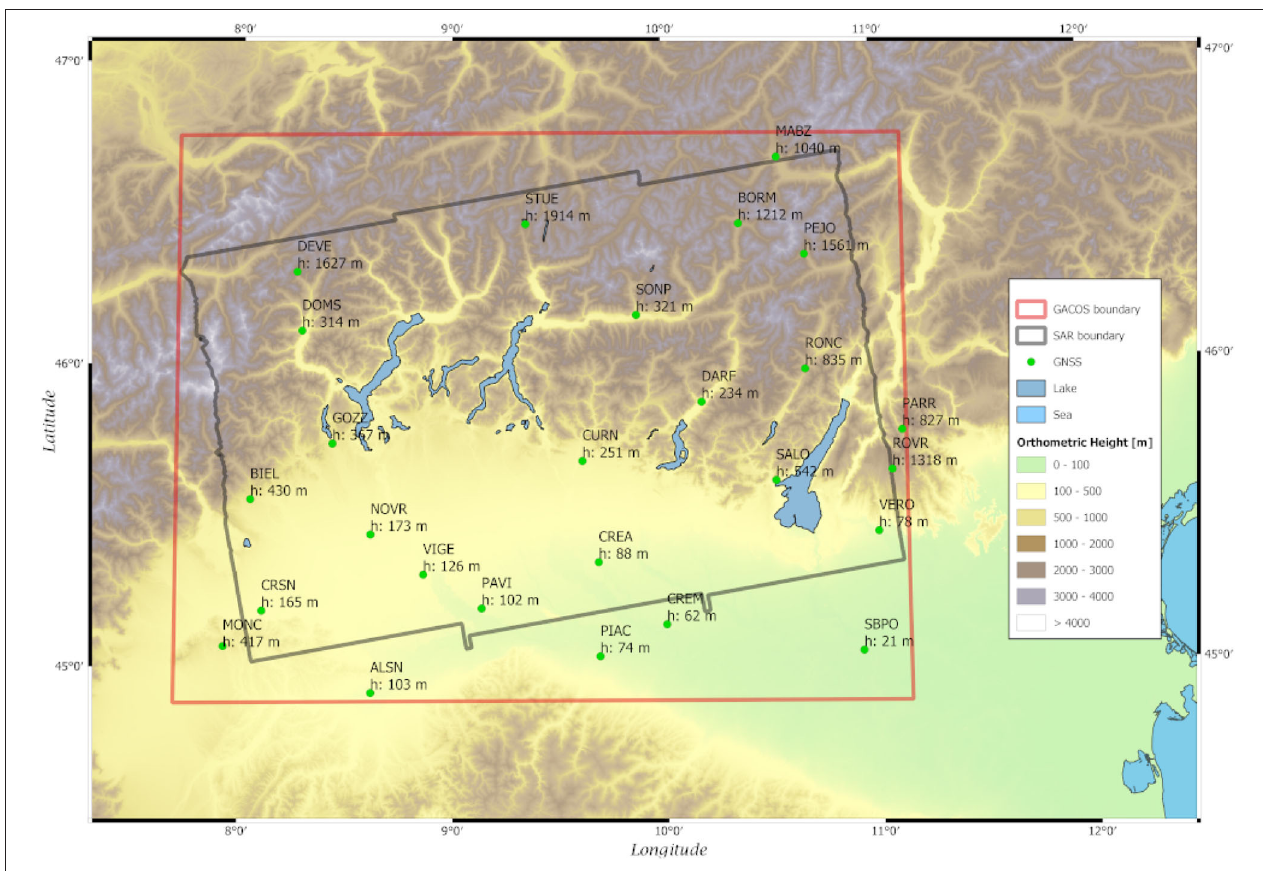
FIGURE 1 | Map of the orography of the region. The gray rectangle indicates the footprint of the SAR observations, while the red rectangle is the area where GACOS data have been downloaded. The green dots indicate the GNSS stations with their code name and altitude,